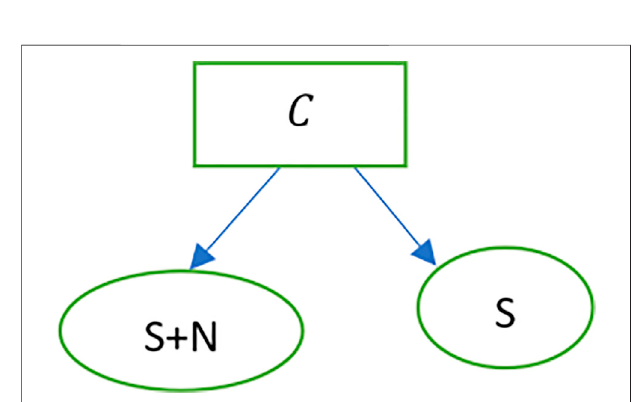
FIGURE 13 | Stimulus sheaf as a